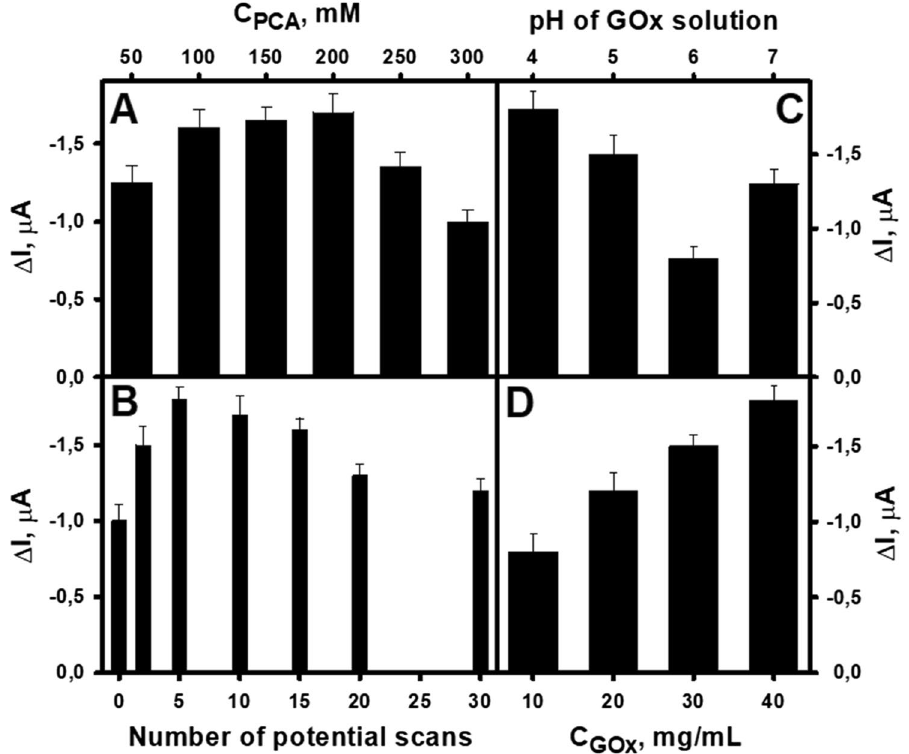
Figure 3. Optimization of additional PPCA layer electrochemical synthesis and GOx immobilization conditions. (A) Optimization of PCA concentration. Constant experimental conditions: potential scan rate of 0.1 V/s, 10 scans. (B) Optimization of the number of scans. Constant experimental conditions: 200.0 mM of PCA, potential scan rate of 0.1 V/s. Optimization of GOx solution pH (C) and concentration (D) . Experimental conditions for the synthesis of PB-PPCA: 1.0 mM of FeCl 3 and K 3 [Fe(CN) 6 ], 35.0 mM of PCA, potential scan rate of 0.1 V/s, 50 scans. GOx concentration: 40.0 mg/mL at pH 4.0 (A – C). GOx solution pH: 4.0 (A, B, D). Measurement conditions: applied potential of + 0.1 V, A-PBS-KCl, pH 6.0, 7.97 mM of